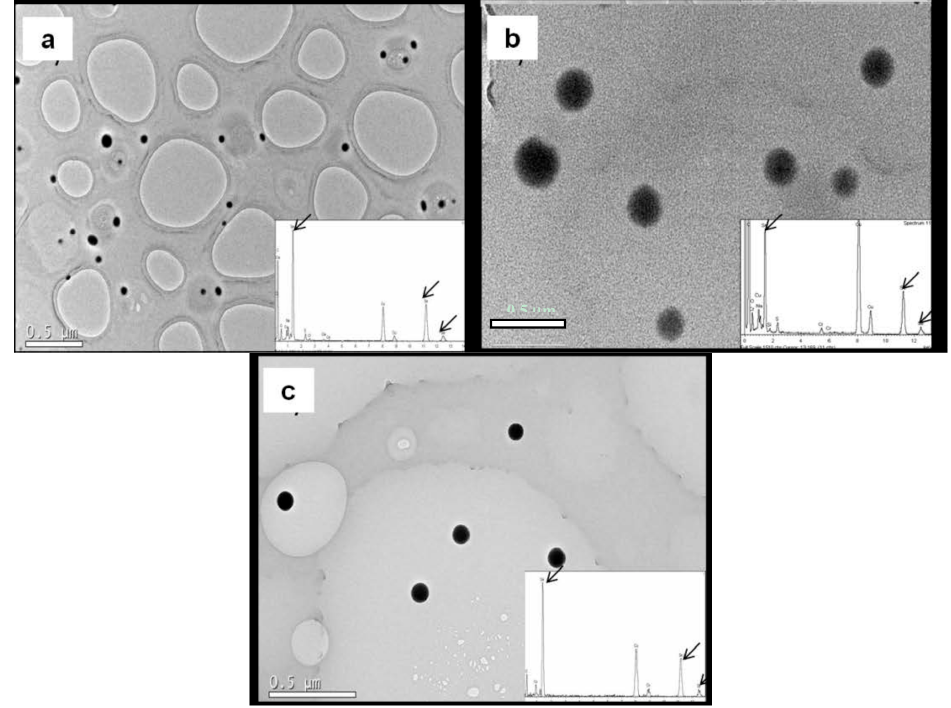
Figure 1. Transmission electron microscopy (TEM) images and X-ray energy dispersive spectroscopy (XEDS) spectrum of chitosan selenium nanoparticles (CS-SeNPs) (56 ± 5 nm) ( a ), Ethoxilated-SeNPs (53 ± 6 nm) ( b ) and hydroxyethyl cellulose (HEC)-SeNPs (60 ± 6 nm) ( c ) at pH = 5, T = 20 ± 1 °C. Black arrows indicate the Se emission peaks consisting of SeL α , SeK α and SeK β at 1.4, 11.22 and 12.49 keV, respectively.